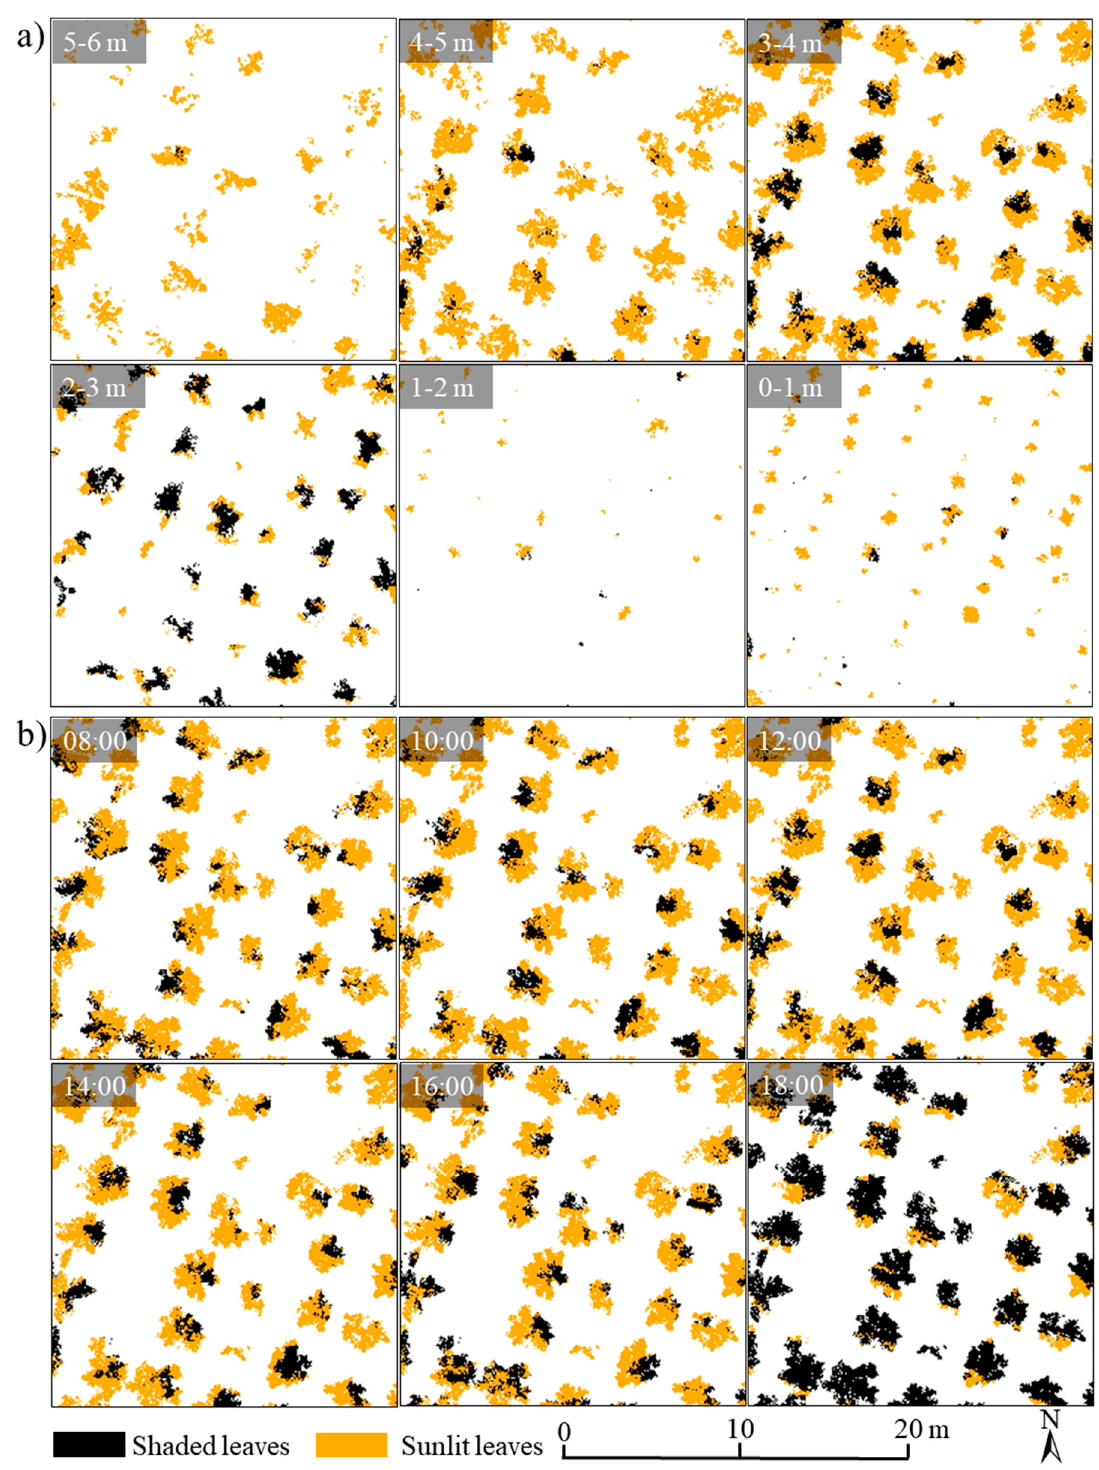
Figure 8. The vertical distribution of sunlit and shaded leaves within a forest canopy at noon (inset a ) and temporal distribution variations of sunlit and shaded leaves with the height ranging from 3 m to 4 m (inset b ) based on the fused point data.